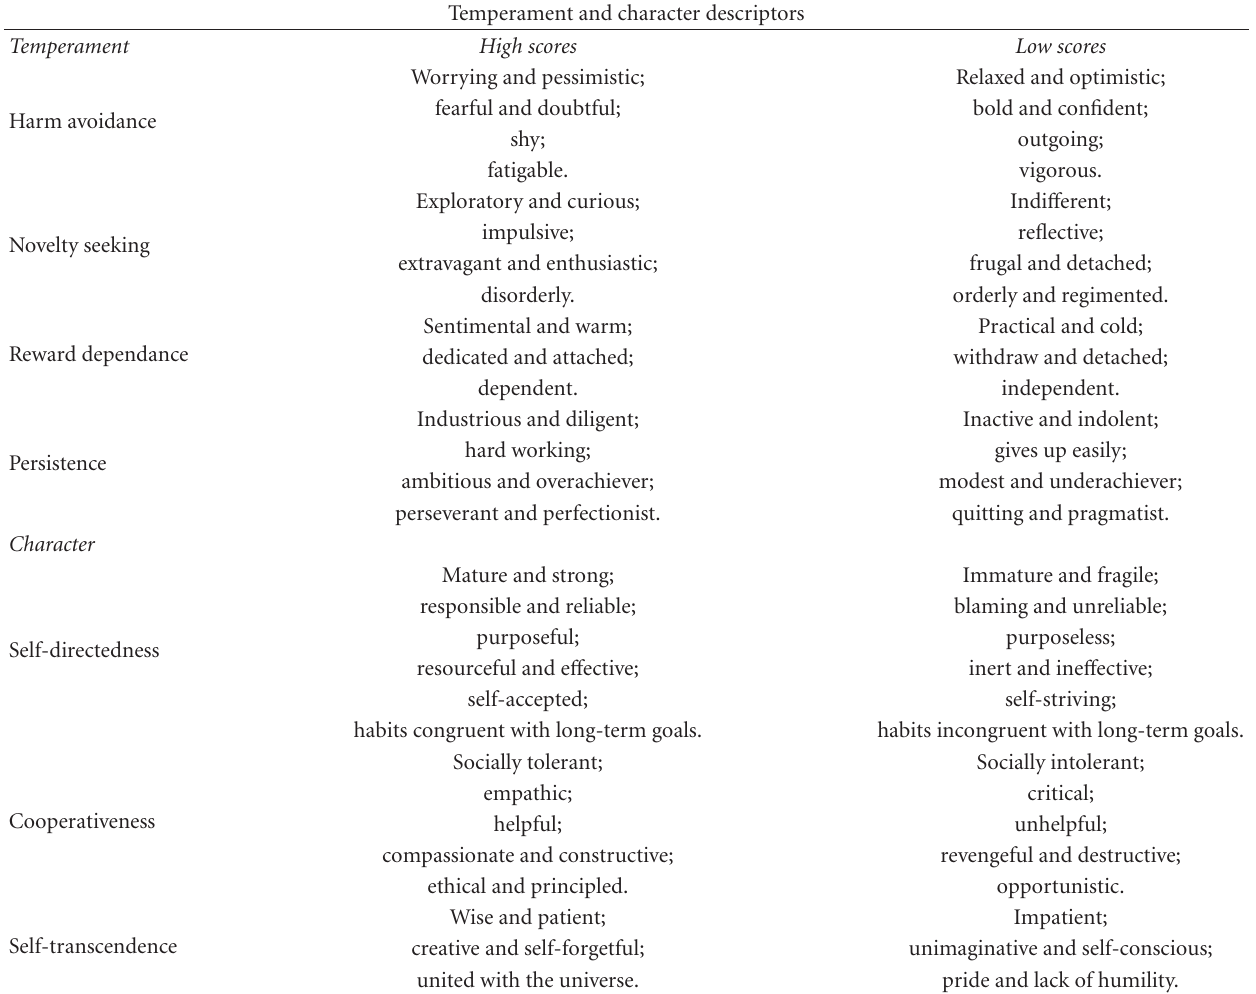
Table 1: Temperament and character description (reproduced with permission of C. R.